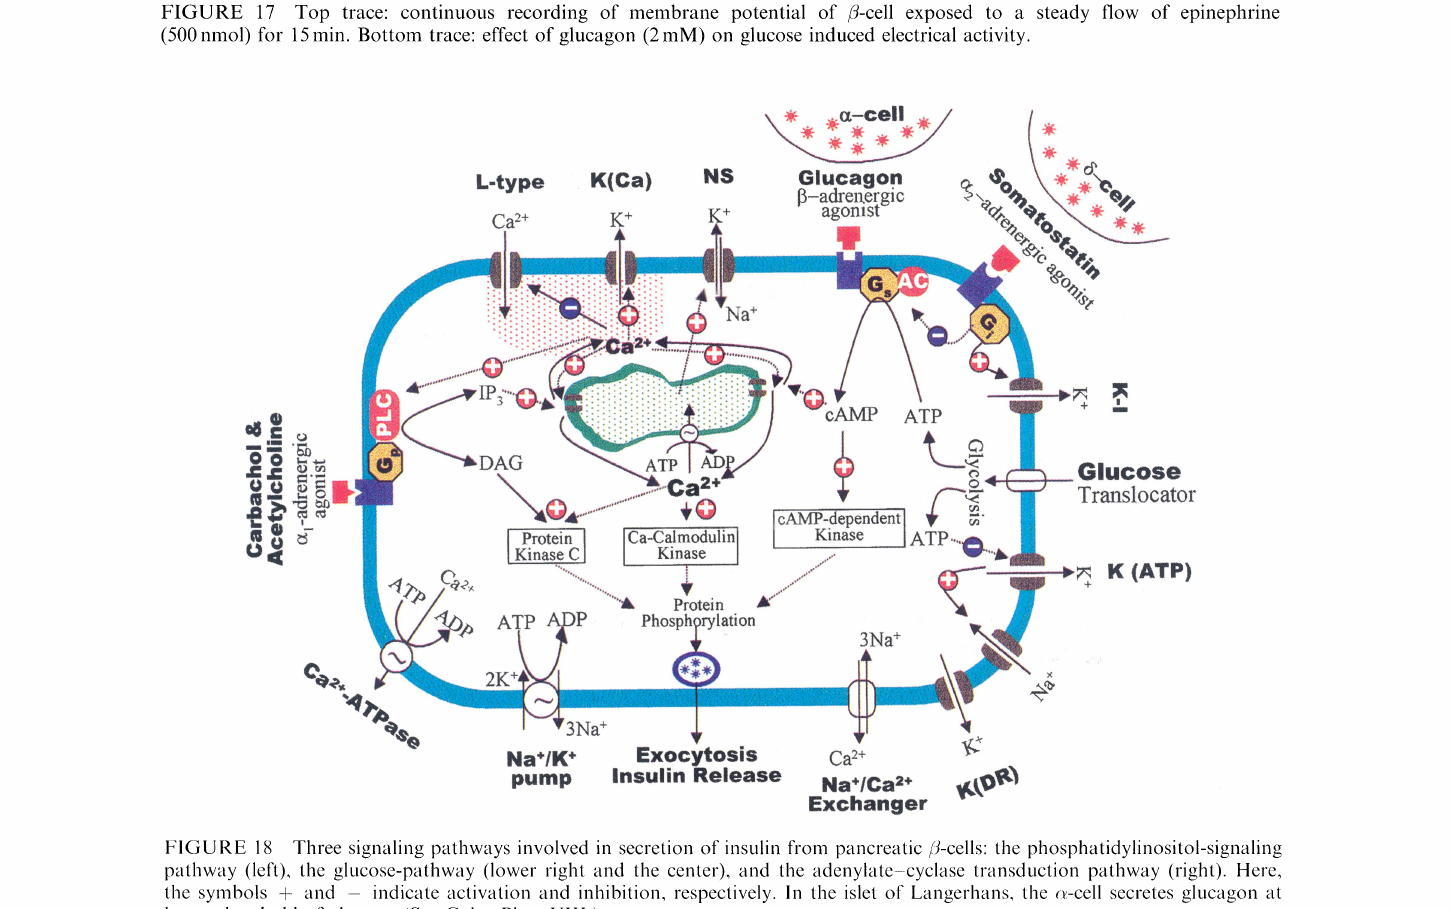
FIGURE 18 Three signaling pathways involved in secretion of insulin ffol-n pancreatic/3-cells: the phosphatidylinositol-signaling pathway (left), the glucose-pathway (lower right and the center), and the adenylate-cyclase transduction pathway (right). Here, the symbols + and indicate activation and inhibition, respectively. In the islet of Langerhans, the cPcell secretes glucagon at lower threshold of glucose. (See Color Plate